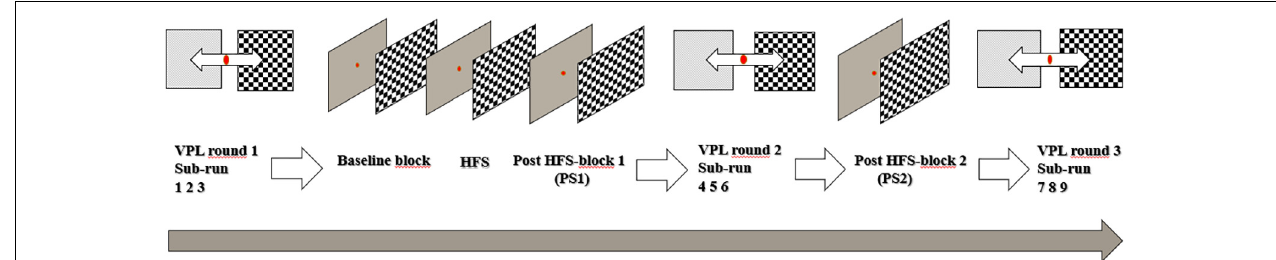
FIGURE 1 | Timeline of the experimental setup.